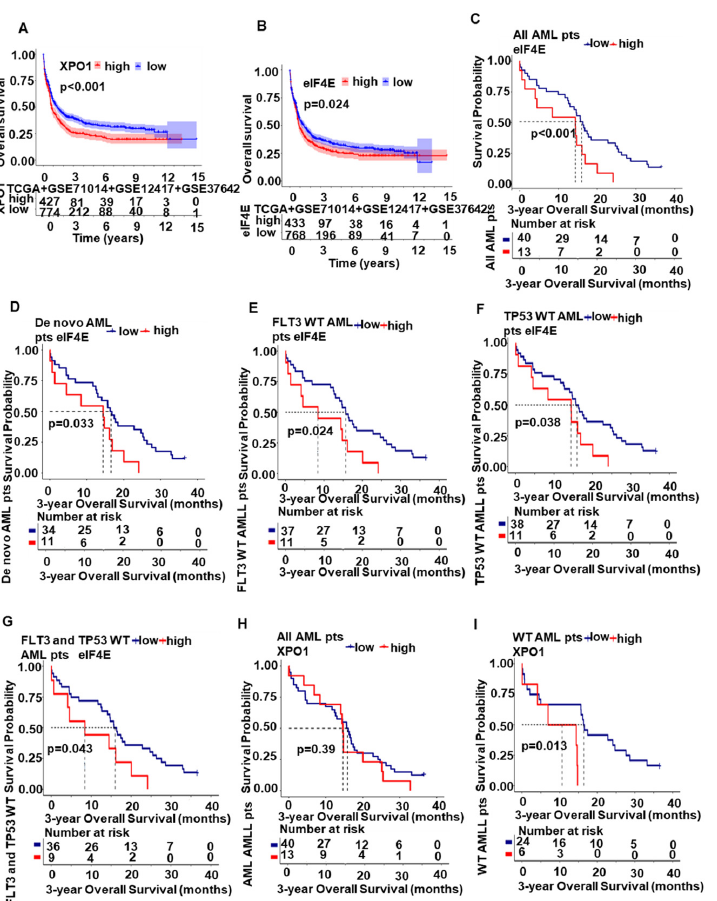
Figure 6. XPO1 / eIF4E was associated with a worse prognosis. ( A ) Overall survival of AML patients with high XPO1 expression (n = 427) and low XPO1 expression (n = 774) based on the combined database (TCGA + GSE71014+ GSE12417 + GSE37642). ( B ) Overall survival of AML patients with high eIF4E expression (n = 433) and those with low eIF4E expression (n = 768) according to the combined database (TCGA + GSE71014 + GSE12417 +GSE37642). ( C , D ) The 3-year overall survival from